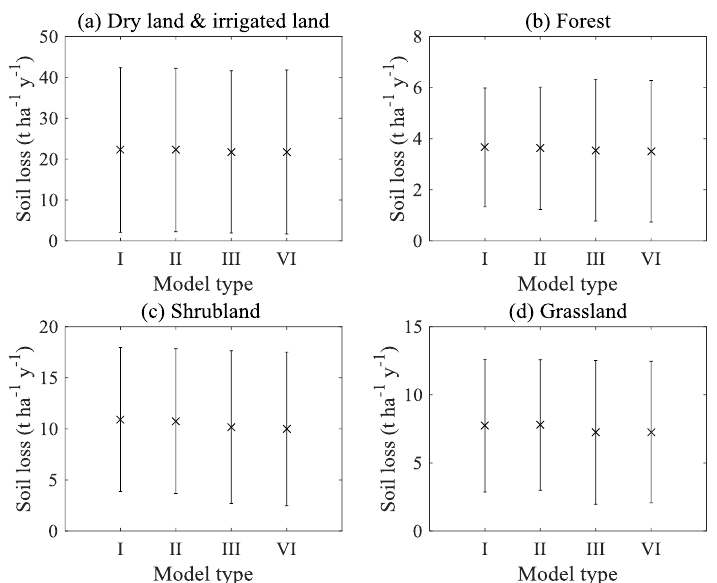
Figure 9. Error bar plot of soil loss rates for four models for different land uses: (a) dry land and irrigated land, (b) forest, (c) shrubland, and (d) grassland. The star symbols stand for the mean values and the error bars stand for standard deviations. Table 4. Annual soil loss amount, mean rate, and main sources by Model VI for 10 prefecture cities in Shaanxi Province. Prefecture Area Amount Mean rate Source (%) city (10 4 ha) (10 6 tyr − 1 ) (tha − 1 yr − 1 ) Dry land and Forest Shrub Grass irrigated land land land Xi’an